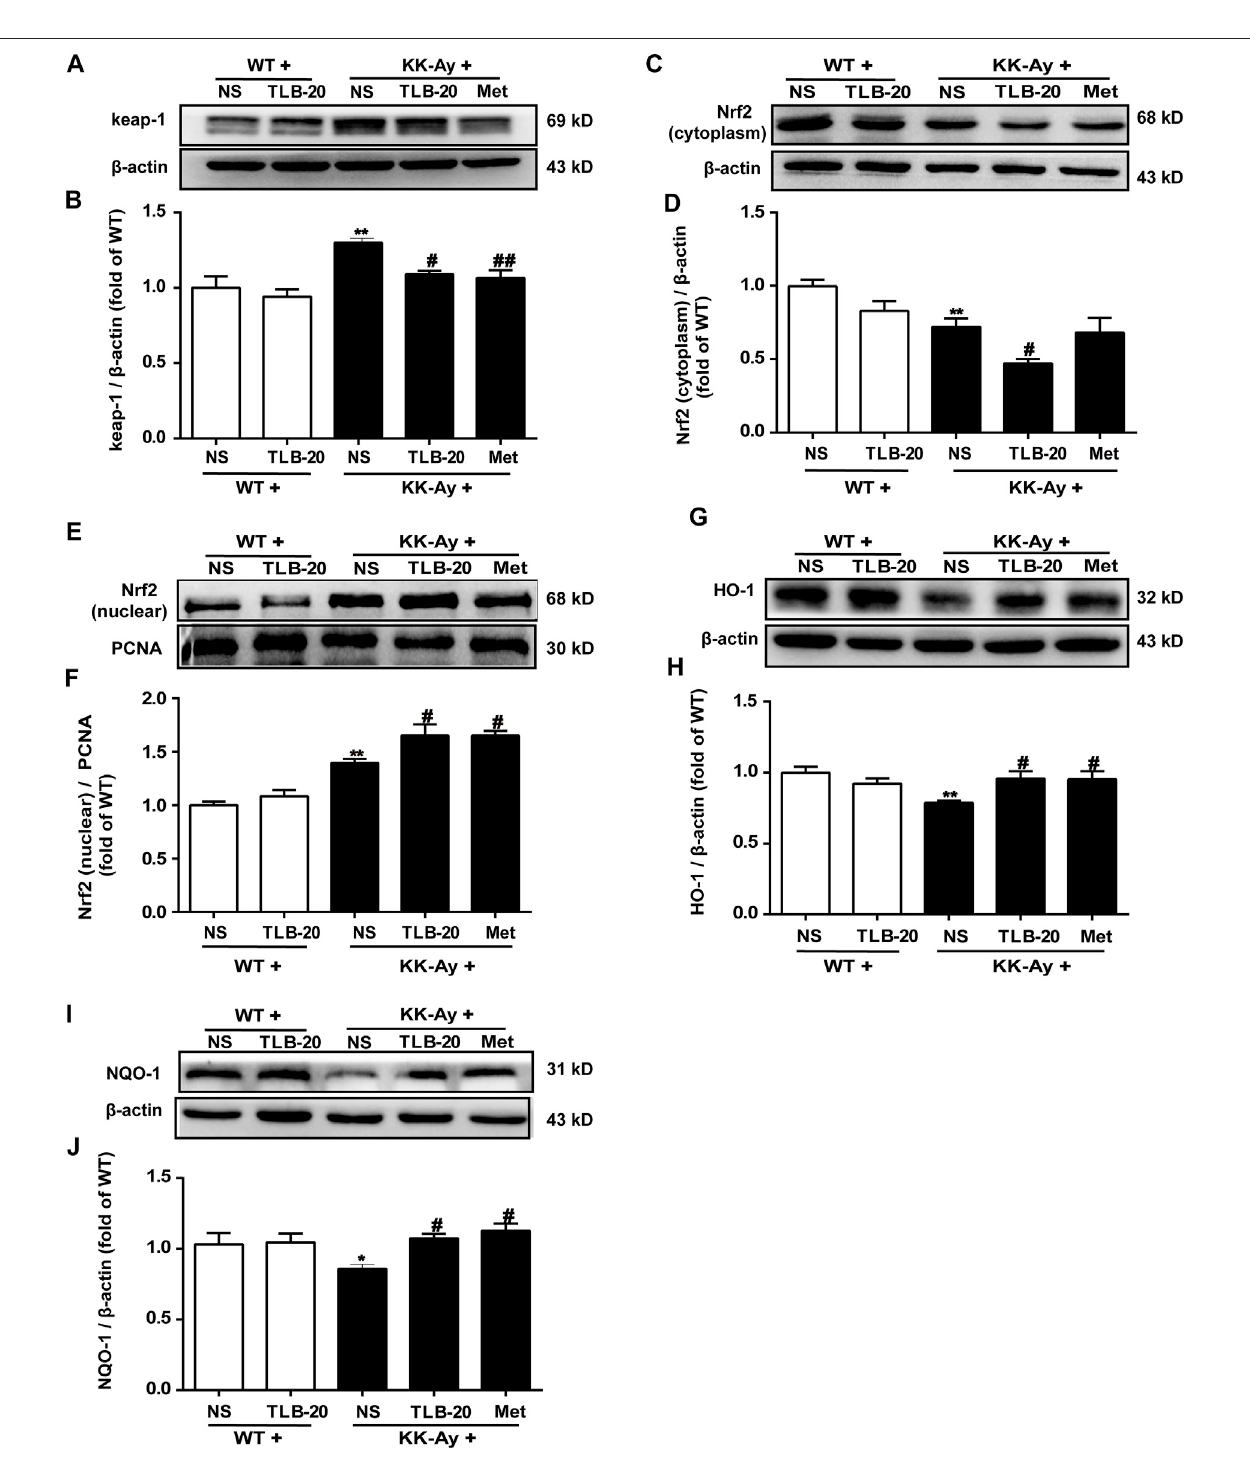
FIGURE 7 | TLB inhibited oxidative stress via activating the Nrf2/ARE signaling pathway in the pancreas of KK-Ay mice. (A) Representative bands of keap1. (B) Quanti fi cation of keap1 protein expression. (C) Representative bands of cytoplasm Nrf2. (D) Quanti fi cation of cytoplasm Nrf2 protein expression. (E) Representative bands of nuclear Nrf2. (F) Quanti fi cation of nuclear Nrf2 protein expression. (G) Representative bands of HO-1. (H) Quanti fi cation of HO-1 protein expression. (I) Representativebands ofNQO-1. (J) Quanti fi cation ofNQO-1protein expression. *p < .05, **p < .01 vs. WTgroup; # p < .05, ## p < .01 vs. KK-Aygroup; n =4-5per group, mean ±